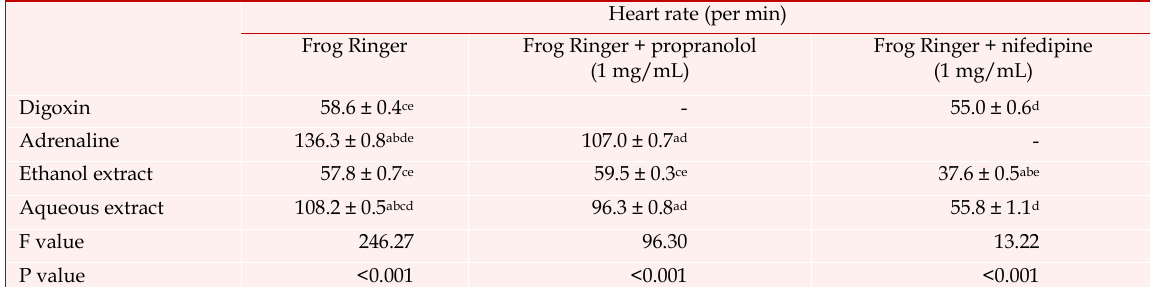
Effect of Premna serratifolia extract on heart rate using isolated frog heart perfusion technique